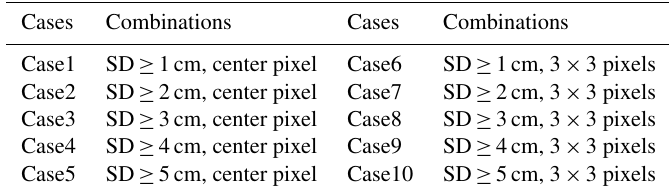
Table 2. A short summary of all the combinations of thresholds. Cases